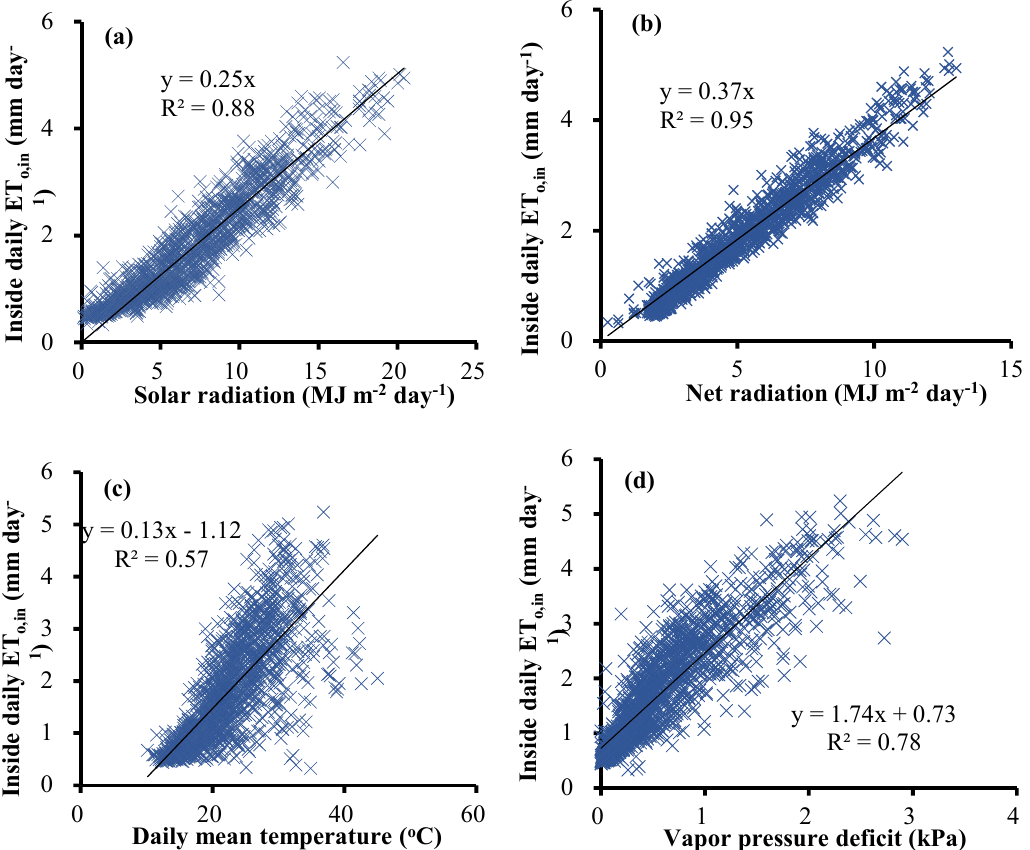
Figure 12. Relationships between inside reference crop evapotranspiration (ET o,in ) and solar radiation ( a ), net radiation ( b ), air temperature ( c ) and vapor pressure deficit ( d ) inside the sunken solar greenhouse.